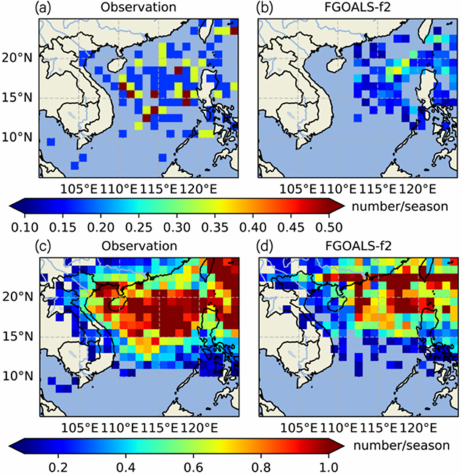
Figure 1. The densities of genesis ( a , b ) location and track ( c , d ) of tropical cyclones (TC) in the South China sea (SCS). Both the observation and the hindcasts are analyzed in a 1 ◦ × 1 ◦ equidistance grid box with six-hour